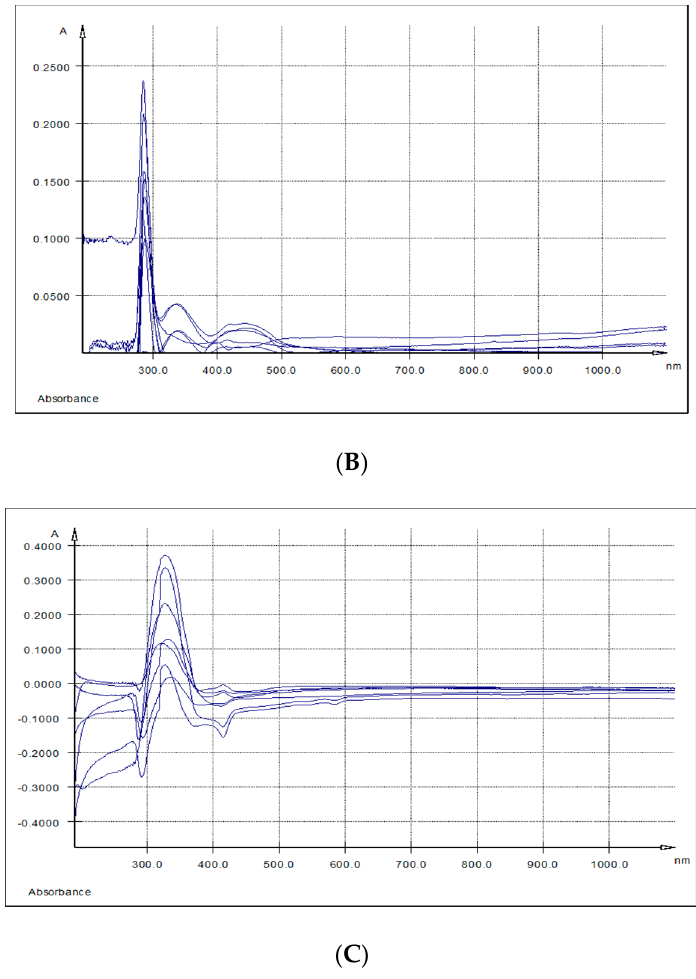
Figure 4. UV-Vis spectra: ( A ) Differences between spleen samples originating from the experimental (5% GP diet) and the control (no GP diet) groups; ( B ) differences between kidneys samples originating from the experimental (5% GP diet) and the control (no GP diet) groups; ( C ) differences between liver samples originating from the experimental (5% GP diet) and the control (no GP diet) groups.